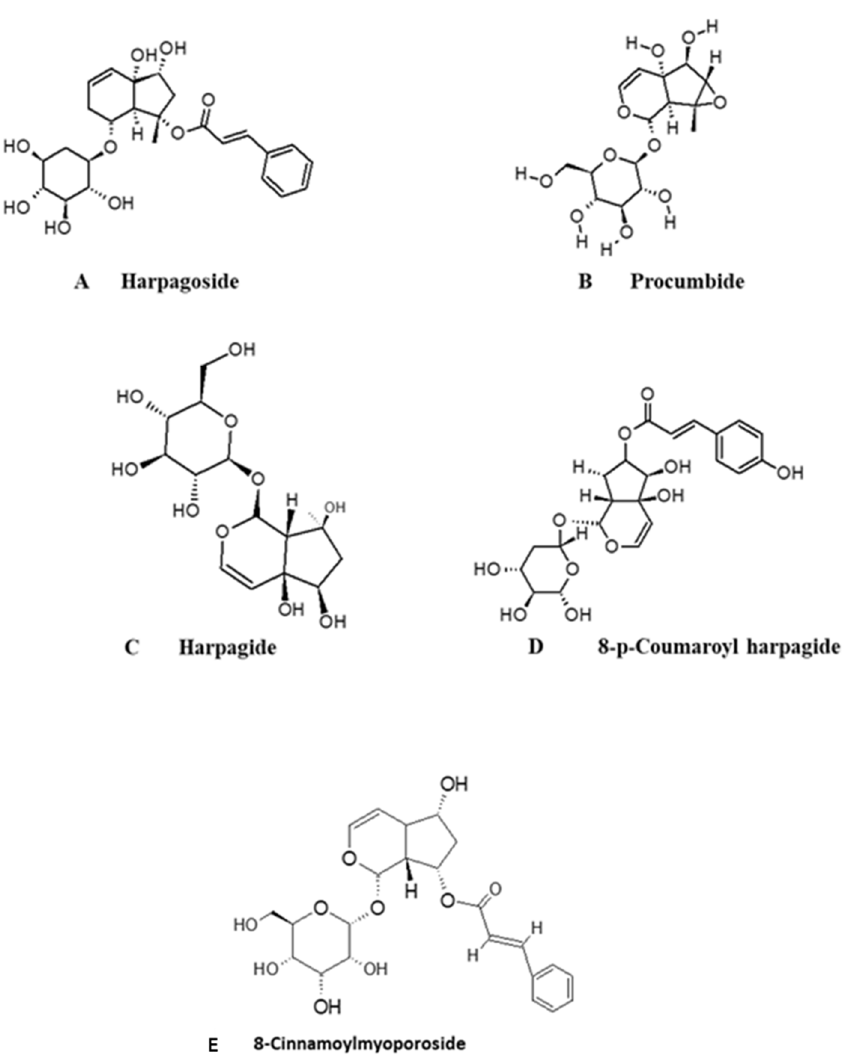
Figure 3. Chemical structures of the major iridoids glycosides and phenylethanoid from H. procum- bens